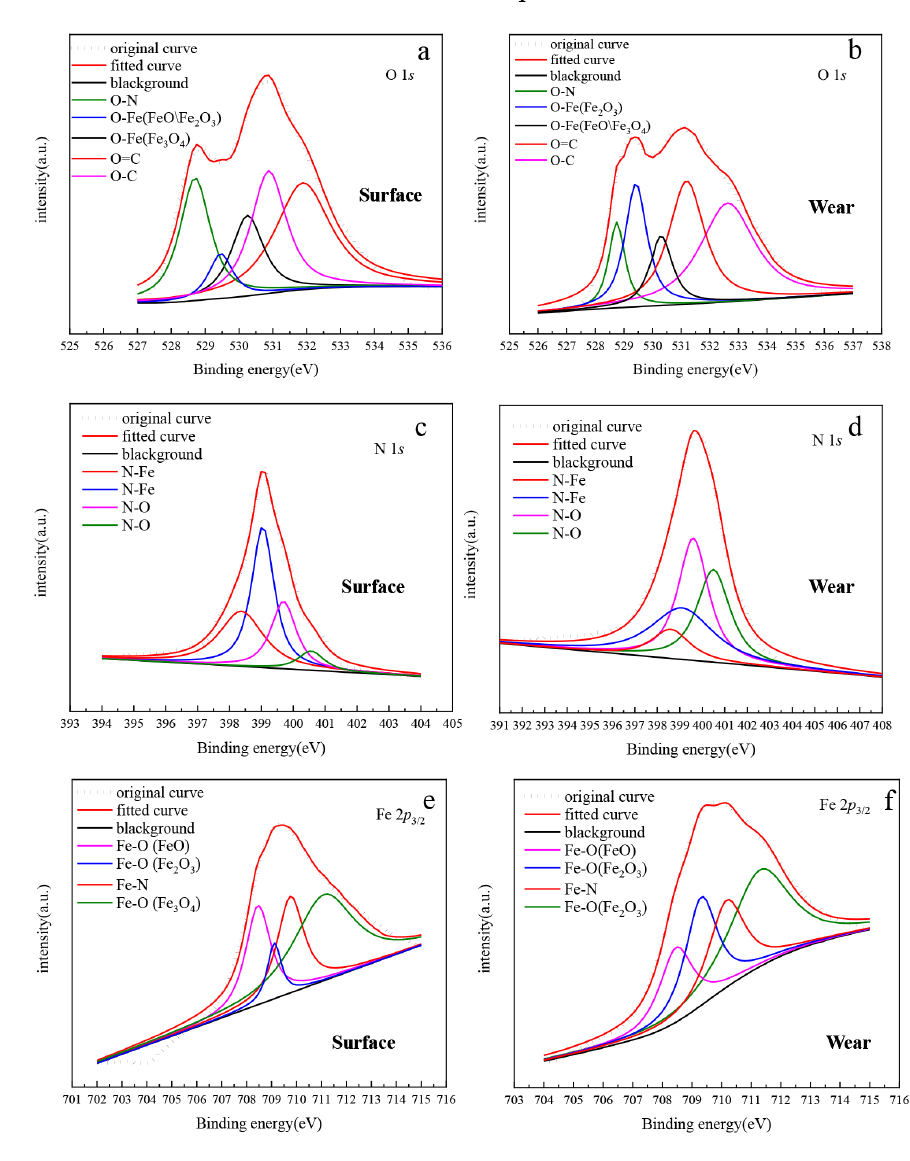
Figure 11. XPS deconvoluted profiles for (A) O 1s, (B) N 1s, (C) Fe 2p3/2 peaks on the nitrided surface and the wear scars of the HCSPN